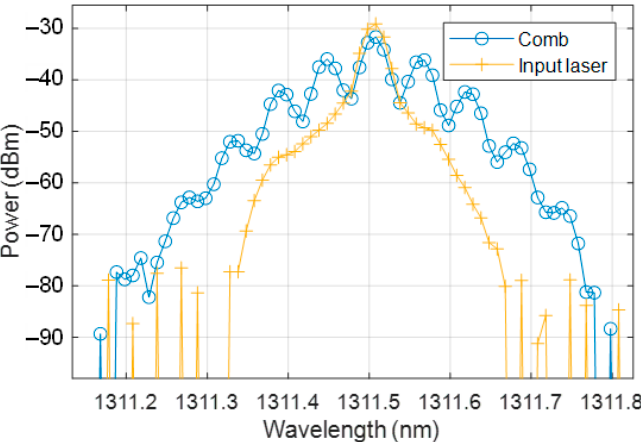
Figure 6. Generated dual optical frequency comb detected in an OSA. The fiber was SMF-28. The fiber-optic coupler was a 50:50 dual-wavelength (1310 nm, 1550 nm). The FBG sensor was a weak FBG of 2 cm, low back reflectivity of 12.5% and 1308.2 nm reference Bragg wavelength.